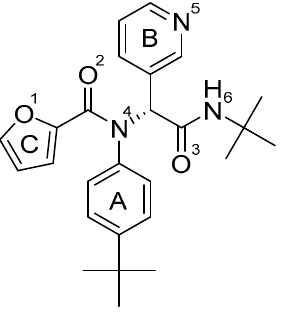
Figure 2. Non-covalent SARS-CoV-2 Mpro inhibitor ML188. Table 1. Docking parameters of derivatives (1a-f), according to the IFD protocol, compared to the